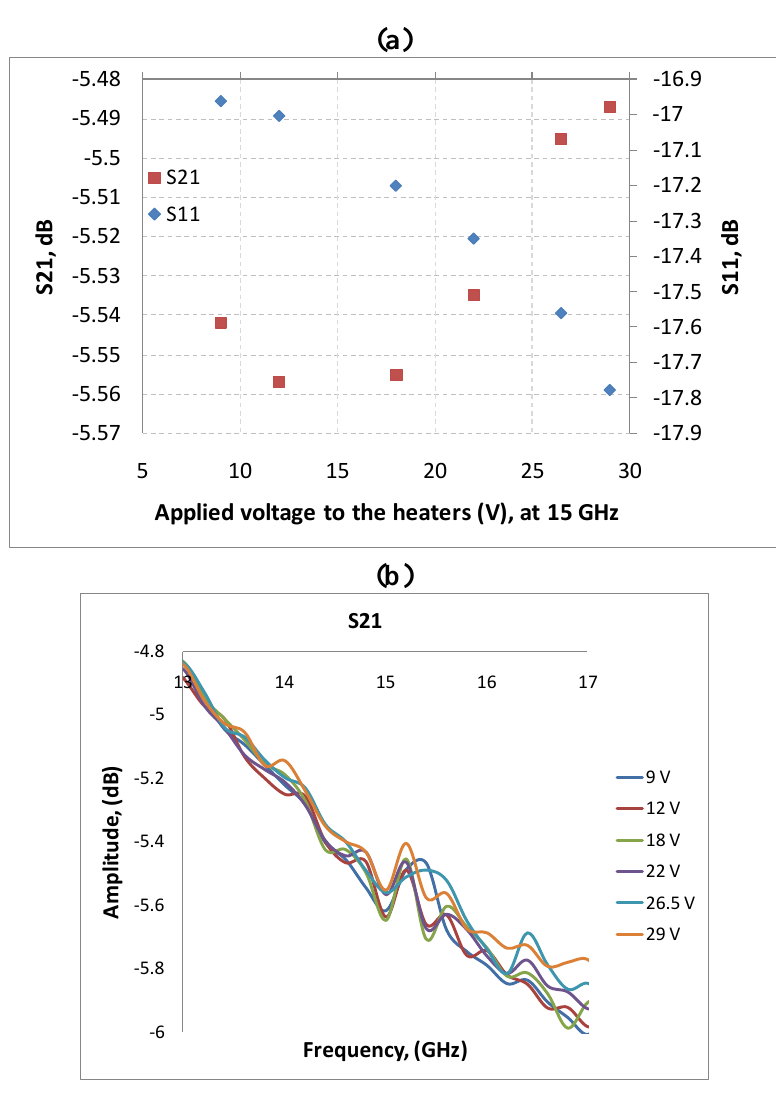
Figure 10. (a) scattering parameters vs. applied voltage to the heaters, f = 15 GHz; (b) S21 in the range of 13 GHz to 17 GHz.